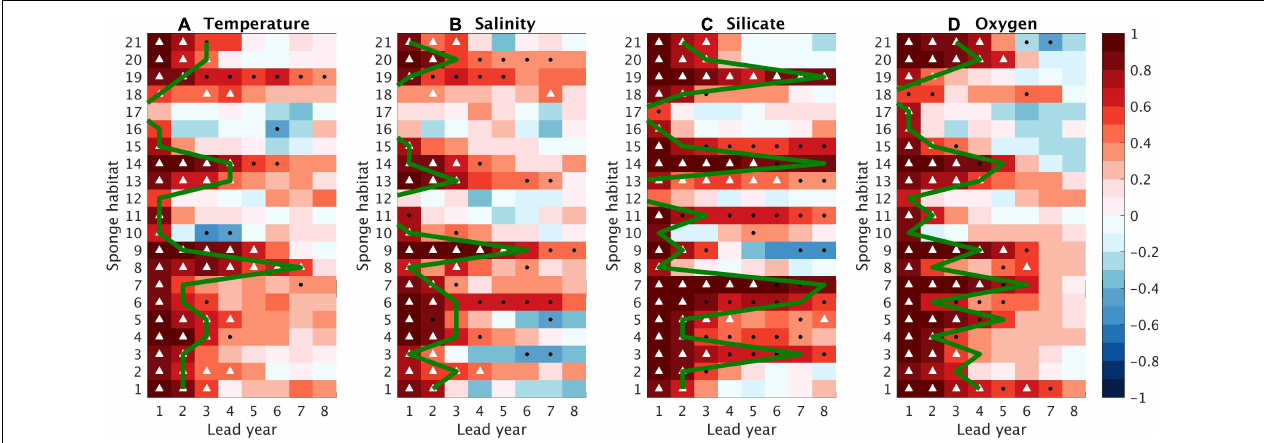
FIGURE 8 | Anomaly correlation coefficients (ACCs, in colors) as a function of lead time ( x axis) and sponge habitat ( y axis) for (A) Temperature, (B) Salinity, (C) Silicate, and (D) Oxygen. White triangles indicate that the ACCs are significant and significantly exceed the ACCs with the uninitialized simulations; black dots denote that the ACCs are significant but not significantly larger than the uninitialized simulations. Green lines indicate the predictability horizon, which is defined as the last lead year when ACCs are significant and the NMAEs are significantly smaller than 1. Significance is tested based on a bootstrap approach with 500 bootstrapped resamples.